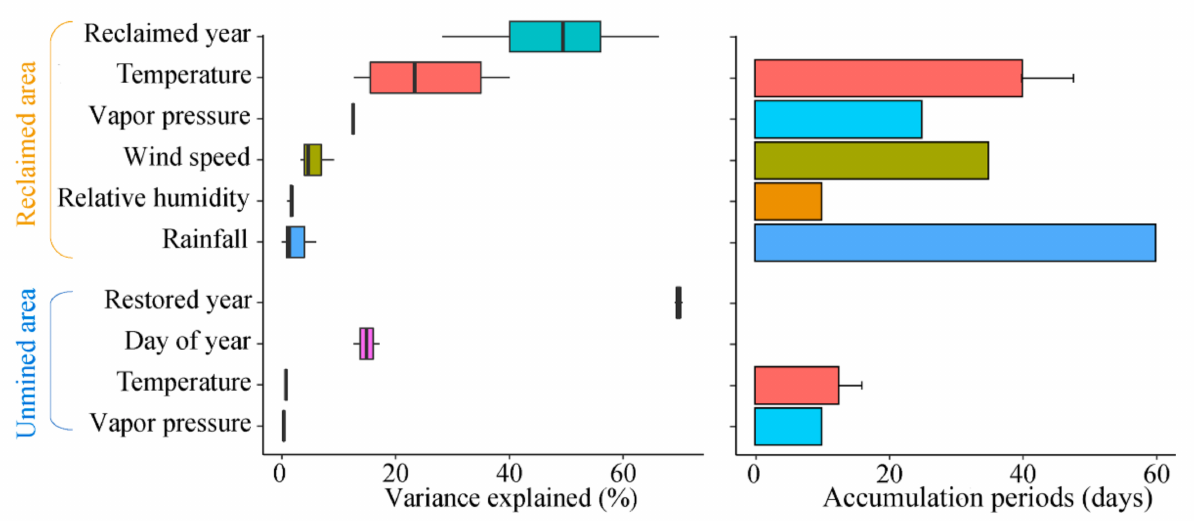
Figure 5. Comparison of vegetation response to climatic variables between reclaimed and unmined